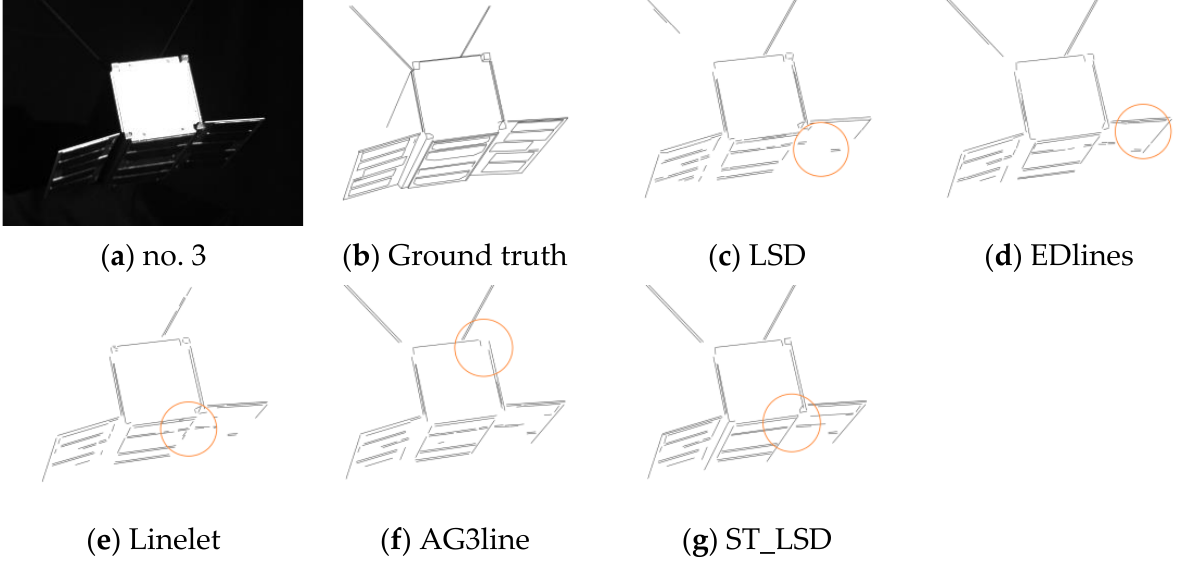
Figure 12. Line segment detection result on image no. 3 of the dataset. Figure 13a shows the situation with low-brightness illumination. LSD still has the problem of detecting too few line segments and failing to detect the line segments on the right side of the square surface. EDlines also has the same problem, but the optimized EDlines performs better than LSD. As shown in the orange circular region in Figure 13e, Linelet detects the most fracture line segments and produces the most fractures. AG3line performs better than the others except for ST_LSD. ST_LSD detects more complete line segments and also rejects some false positives on the